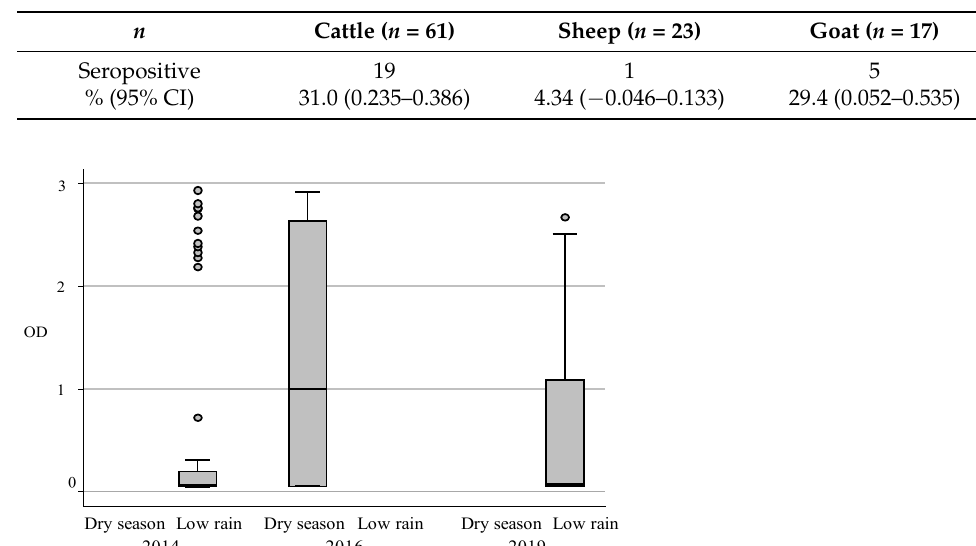
Table 3. Number of seropositive and percentage (95% CI) of animals from 18 single or 13 mixed households sampled in Maasai Mara farms between 2014 and 2019 that were seropositive for CCHF.